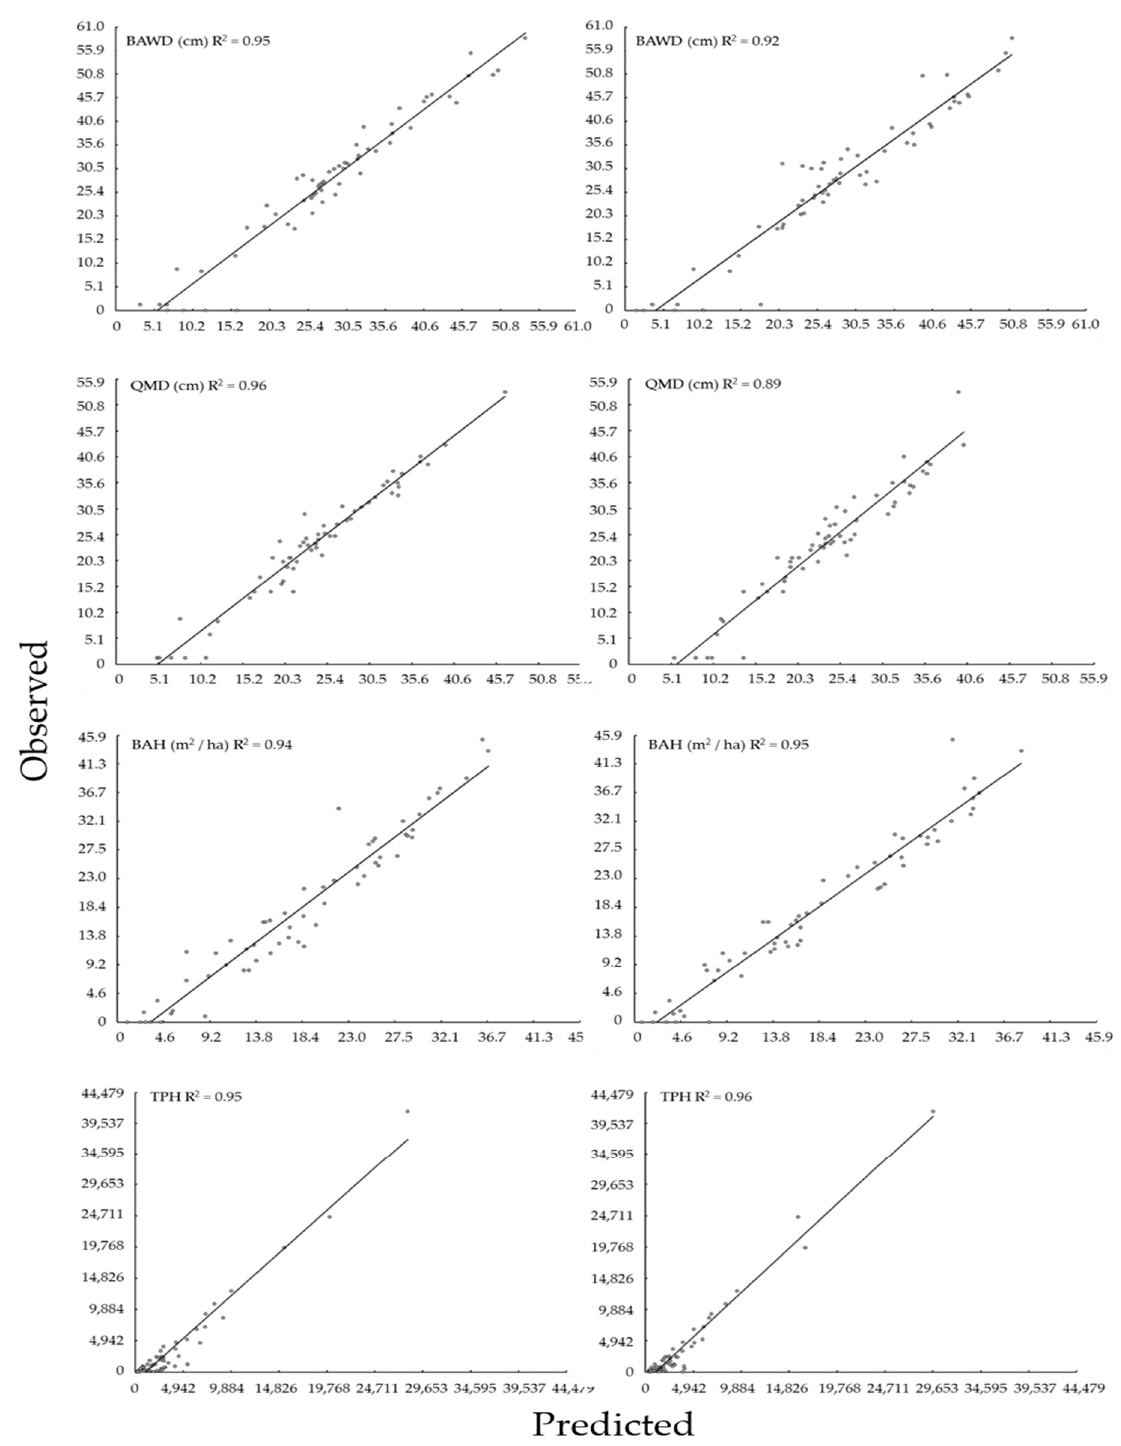
Figure A2. Observed verse predicted values for NAIP (left) and LiDAR (right) based, basal area weighted diameter (BAWD), quadratic mean diameter (QMD), basal area per hectare (BAH), trees per hectare (TPH), best fitting Random Forest models.